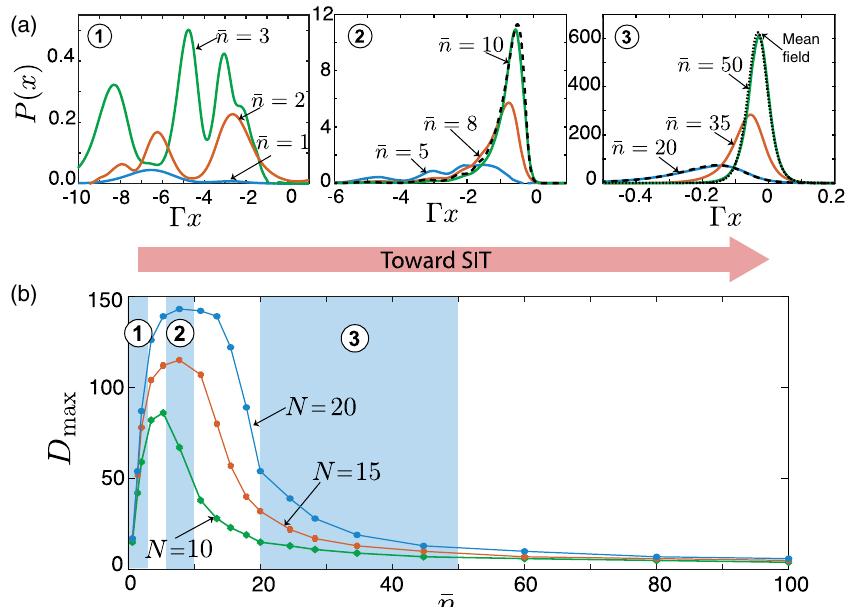
150 . In the max ¼ of max